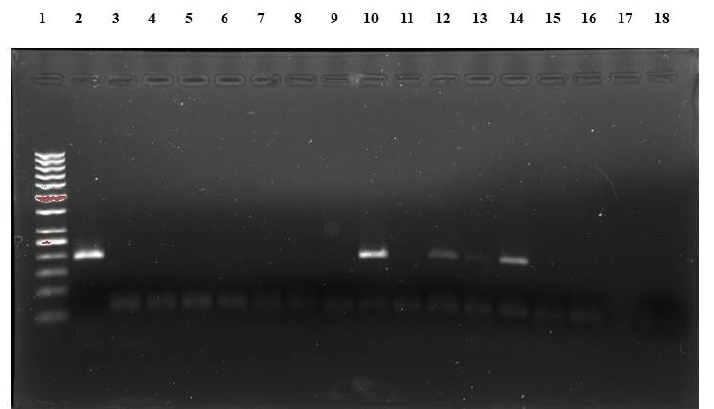
Figure 4. 2% agarose gel electrophoresis. The amplimers shown in the photo correspond to; (1) 50 bp molecular scale marker (Invitrogen ®); (2) positive control; (3) Negative control; (4-9,11,15-18) negative samples; (10,12-14) positive samples for Trypanosoma vivax .